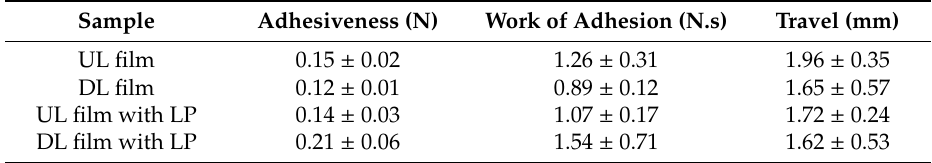
Table 6. The adhesiveness of unloaded and drug-loaded films with and without liver powder, measured on the second day from printing. Average and standard deviations are presented, n = 6.